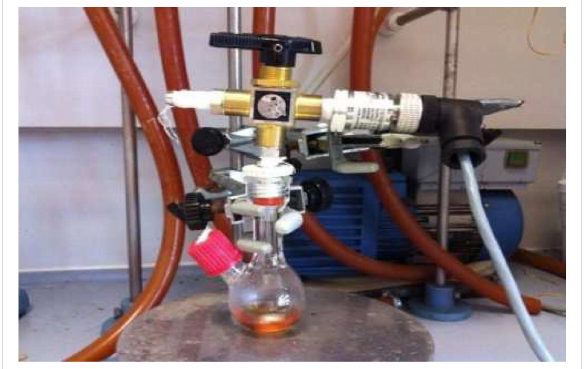
Figure 3: The experimental device for the measurement of N 2 evolu-